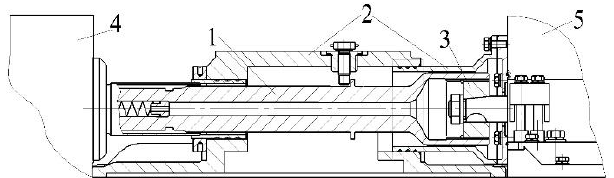
Figure 10. General view of the basic design of the HPFP drive: 1—drive spring; 2—casing; 3—slotted bushing; 4—drive; 5—high-pressure fuel pump.